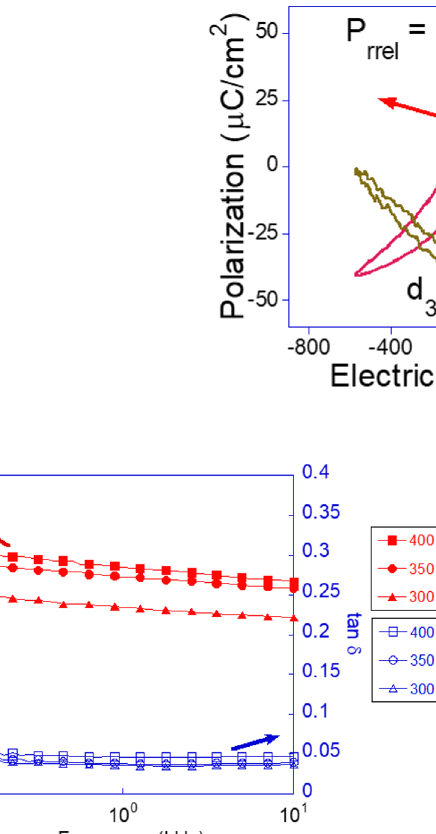
Fig. 5 Strain and P-E response at 1 kHz with 600 kV/cm maxi- mum applied field for 210 nm thick films crystallized for 5 min at 700 °C for a 75 °C per second b 100 °C per second c 125 °C per second and d 150 °C per second. Note P repre- rrel sents the relaxed remanent polarization